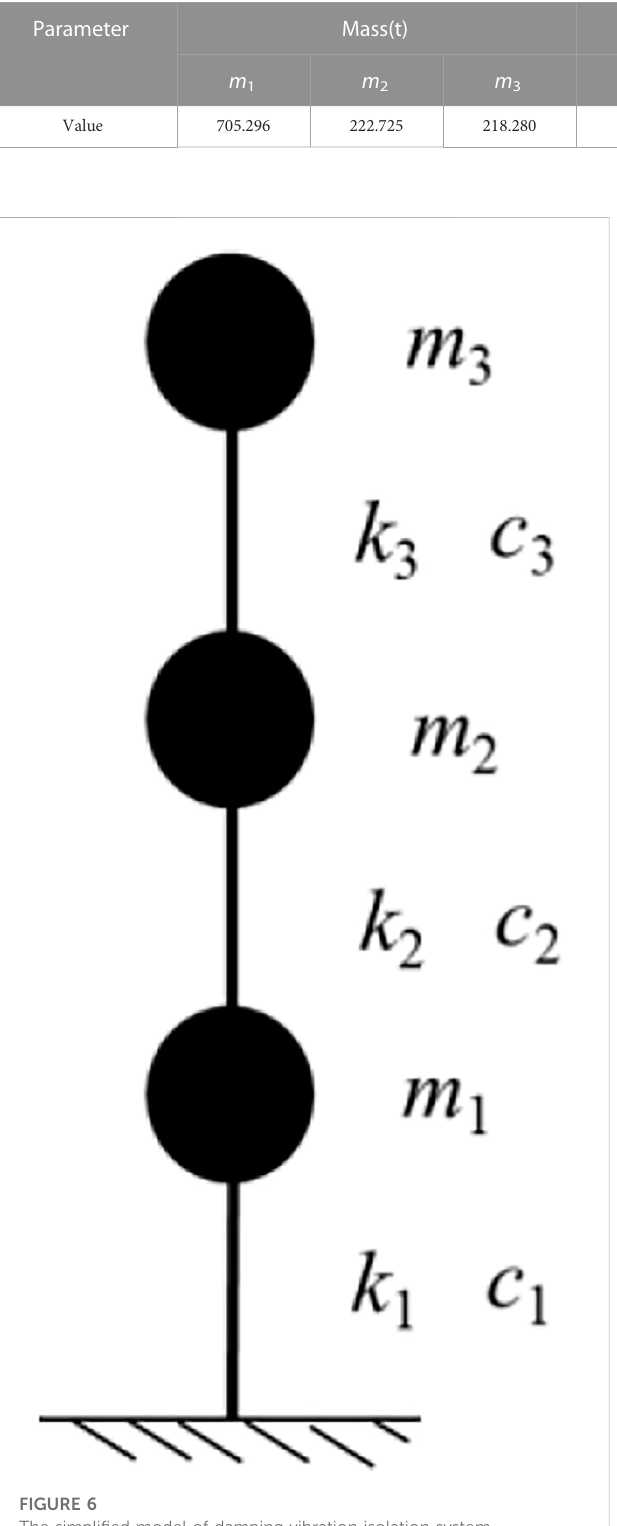
FIGURE 6 The simpli fi ed model of damping vibration isolation system.